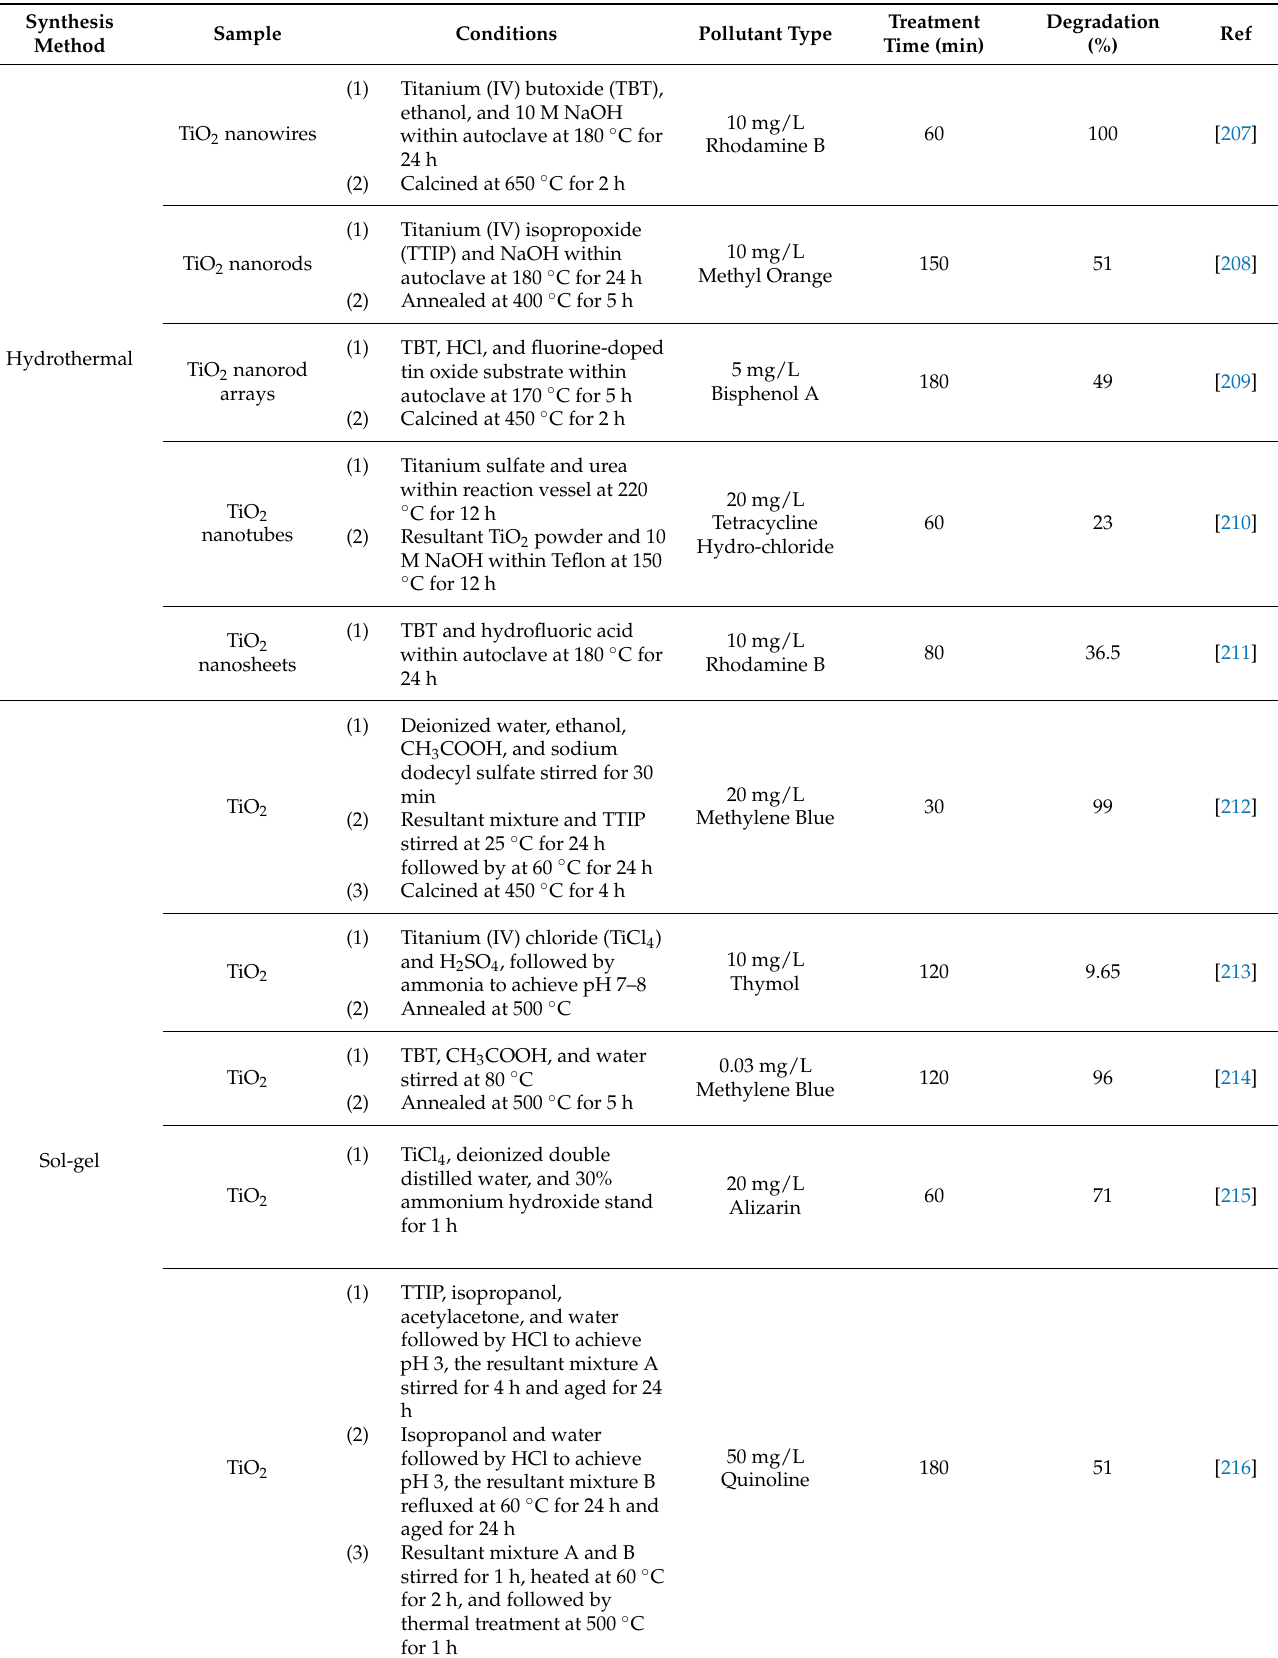
Table 3. Performance of TiO 2 prepared from different synthesis methods in pollutant